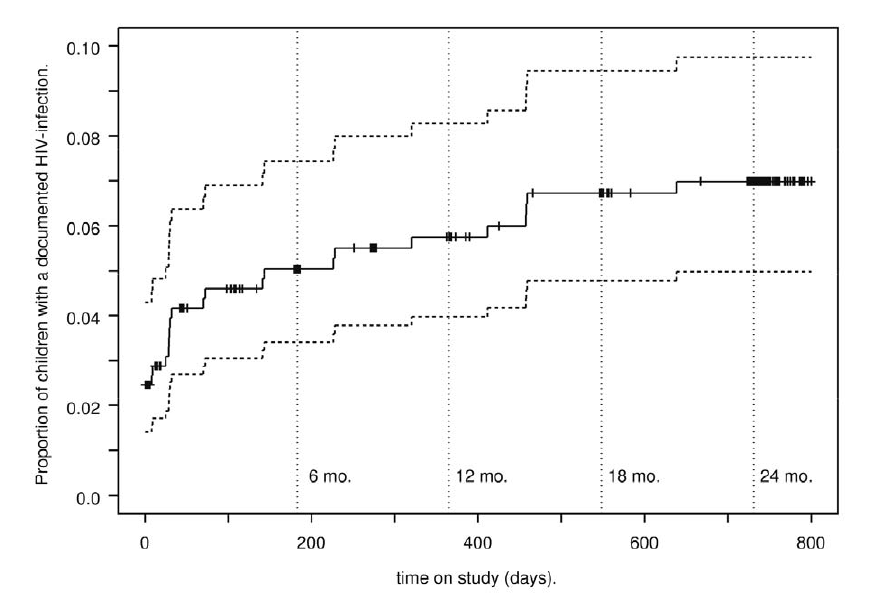
Figure 2. Kaplan-Meier estimates of HIV-transmission rates. Kaplan-Meier estimates of HIV-transmission rates among live-born singletons and first-born infants of mothers who received triple-ARV prophylaxis between 34 wk gestation and 6 mo post partum with 95% CIs.